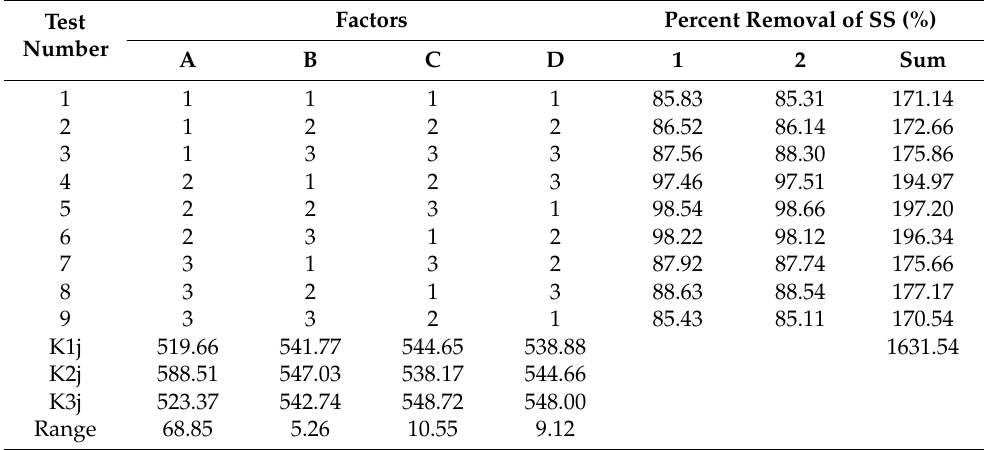
Table 2. The L 9 (3 4 ) orthogonal array test and range analysis for hydraulic conditions.